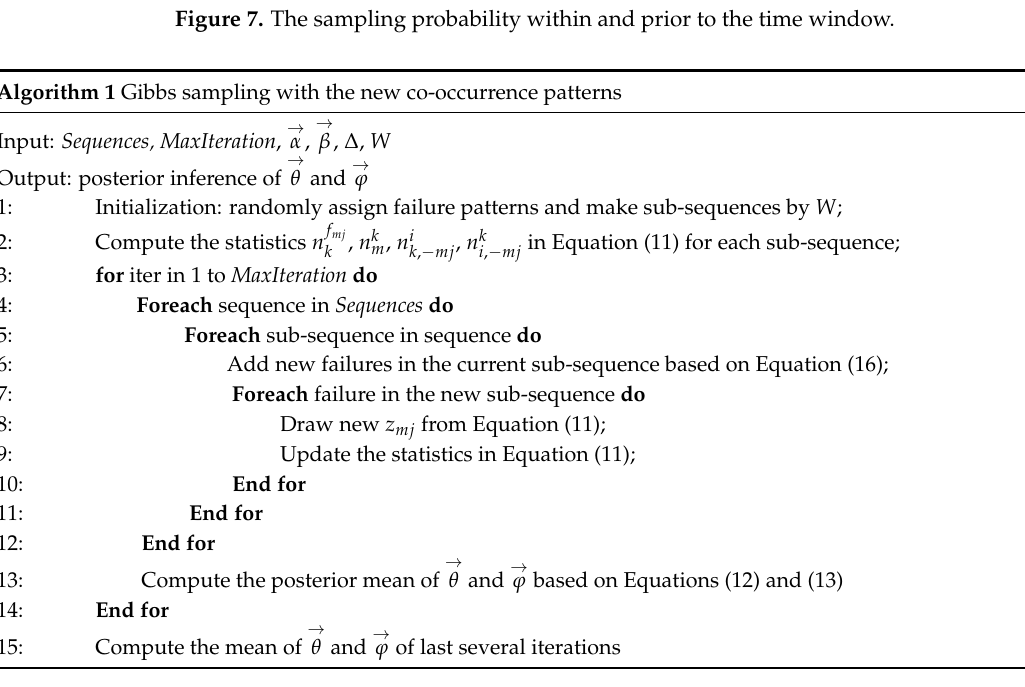
Figure 8. Log analysis framework by the temporal Latent Dirichlet Allocation (TLDA).